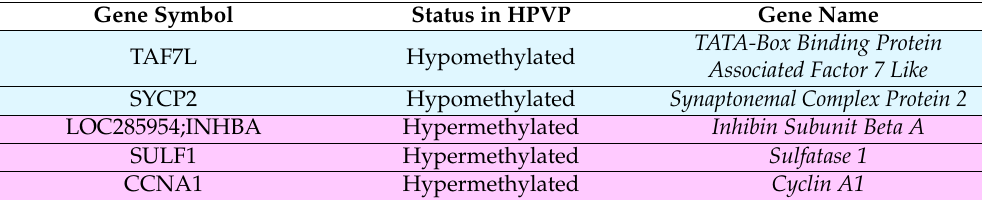
Table 6. Representative top differentially expressed genes and differentially methylated regions filtered by Starburst (FDR cutoff = 1; HPVN group is used as a baseline). Gene Symbol Status in HPVP Gene Name TATA-Box Binding Protein TAF7L Hypomethylated Associated Factor 7 Like SYCP2 Hypomethylated Synaptonemal Complex Protein 2 LOC285954;INHBA Hypermethylated Inhibin Subunit Beta A SULF1 Hypermethylated Sulfatase 1 CCNA1 Hypermethylated Cyclin